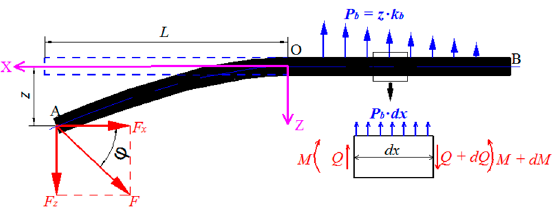
Figure 2. Two-dimensional beam model of the drill-exit fiber for AFRP.